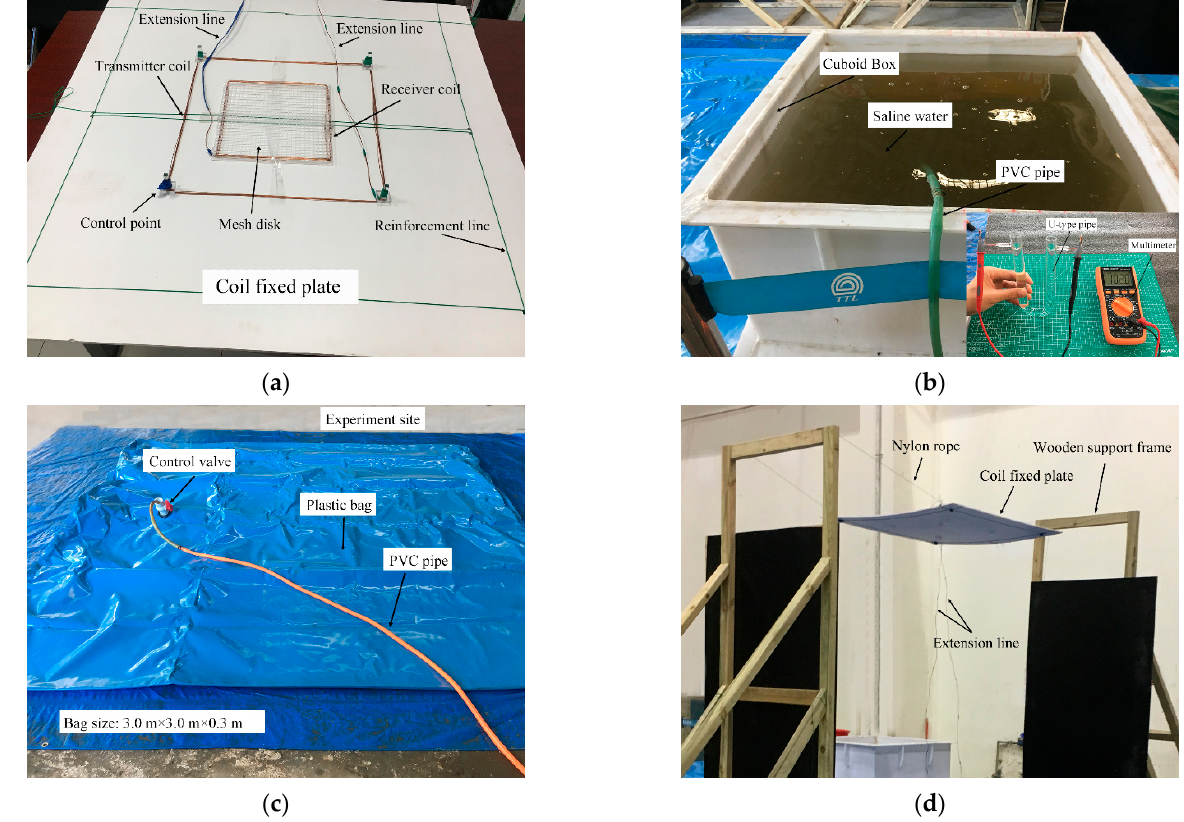
Figure 13. The detailed process of laboratory experiment: ( a ) transmitter coil and receiver coil; ( b ) configured saline water; ( c) customized plastic bag; ( d ) relative position of coil.